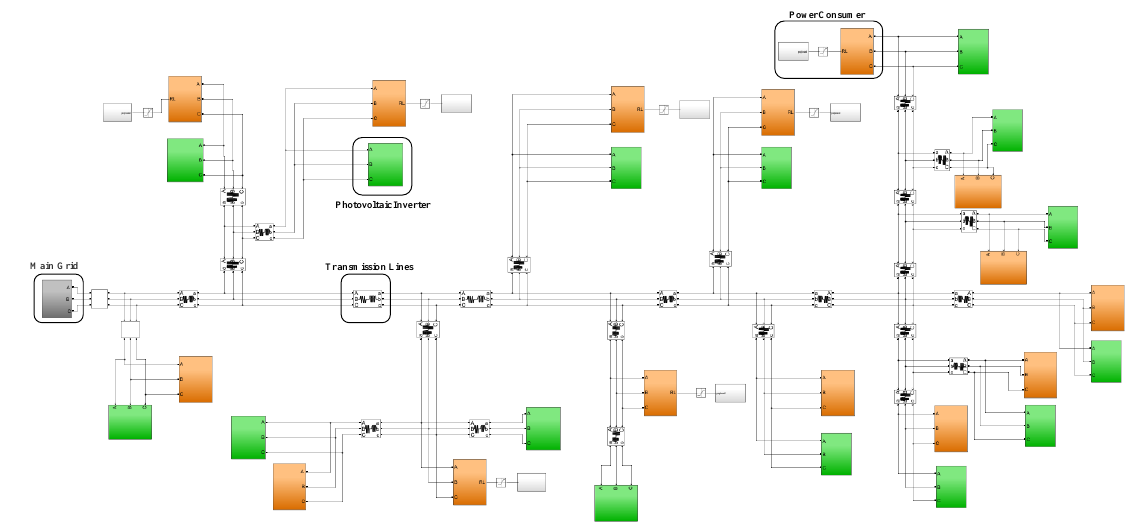
Figure 7. The simulation model with 15 PV inverters (green module) and loads (orange module).